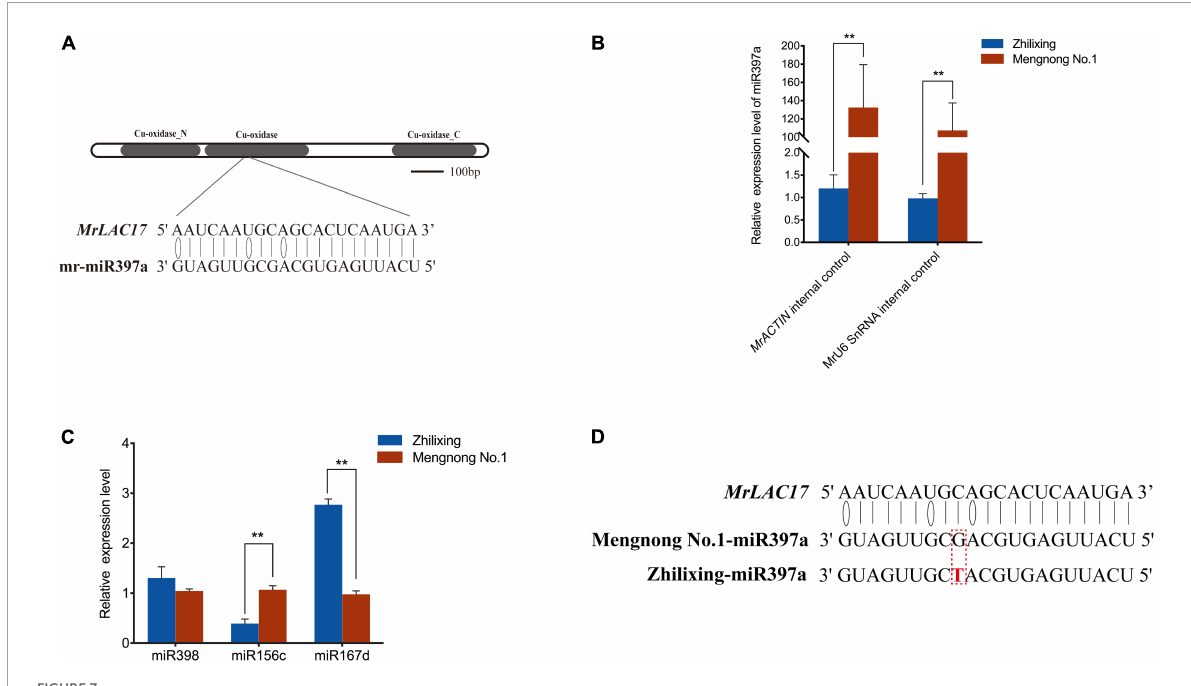
FIGURE7 miR397a was specifically low-expressed in the erect stem cultivar of M. ruthenica . (A) mr-miR397a targets MrLAC17 for cleavage. (B) miRNA-specific qRT-PCR analysis of miR397a in the two M. ruthenica cultivars. Expression level of cultivar Zhilixing was set to 1. MrACTIN and MrU6 SnRNA were used as the internal control. (C) Relative expression results of miRNAs in the two M. ruthenica cultivars. The expression level in Mengnong No.1 was set to 1. MrACTIN was used as the internal control. In (B,C) , values are means ± S.D. of three technical replicates from six biological replicates. Asterisks indicate significant differences between the two indicated samples, as determined by Student’s t -test (** p < 0.01). (D) A single base mutation in miR397a of the erect stem cultivar. The mutated nucleotide is marked in